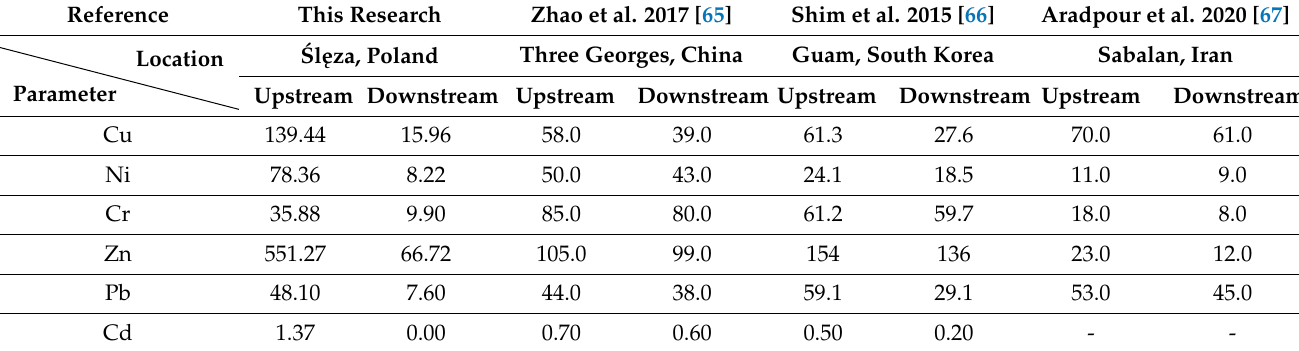
Table 11. Comparison of the mean test results for heavy metals for various research [65–67].